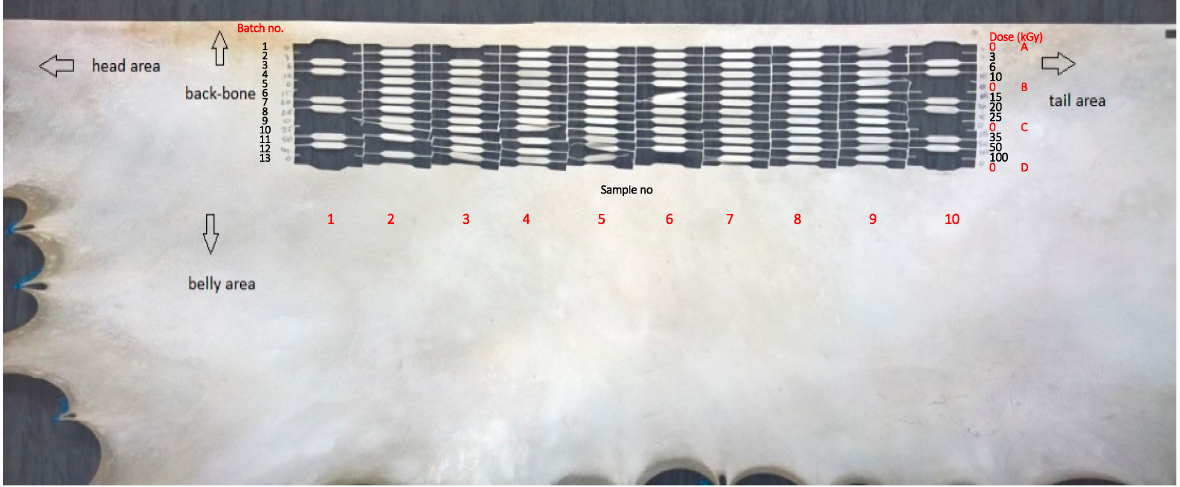
Figure 1. Half skin parchment sample after mechanical tests samples withdraw, with indication of sampling areas (head, backbone, belly, and tail), batches number (left column numbers), sample number (horizontal line numbers), and irradiation doses (right column numbers; in the case of control samples, the batches A, B, C, and D are highlighted also).